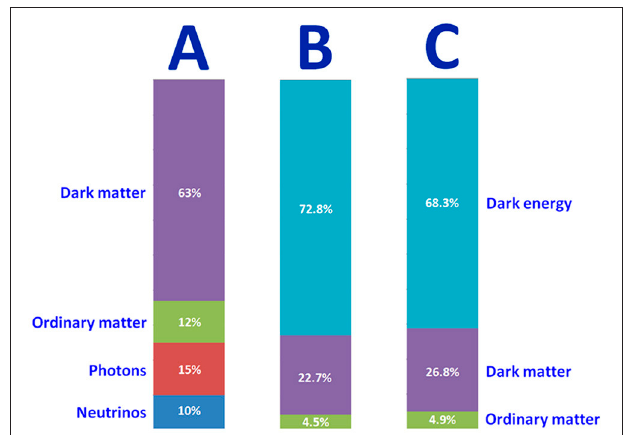
FIGURE 1 | Approximate composition of the universe, (A) when it was 380,000 year-old, and of today’s universe, (B) before and (C) after ESA’s Planck satellite. Although matter alone may have made up most of the early universe, dark energy must now be added to explain the universe’s persistent flatness. Credits: NASA and ESA.